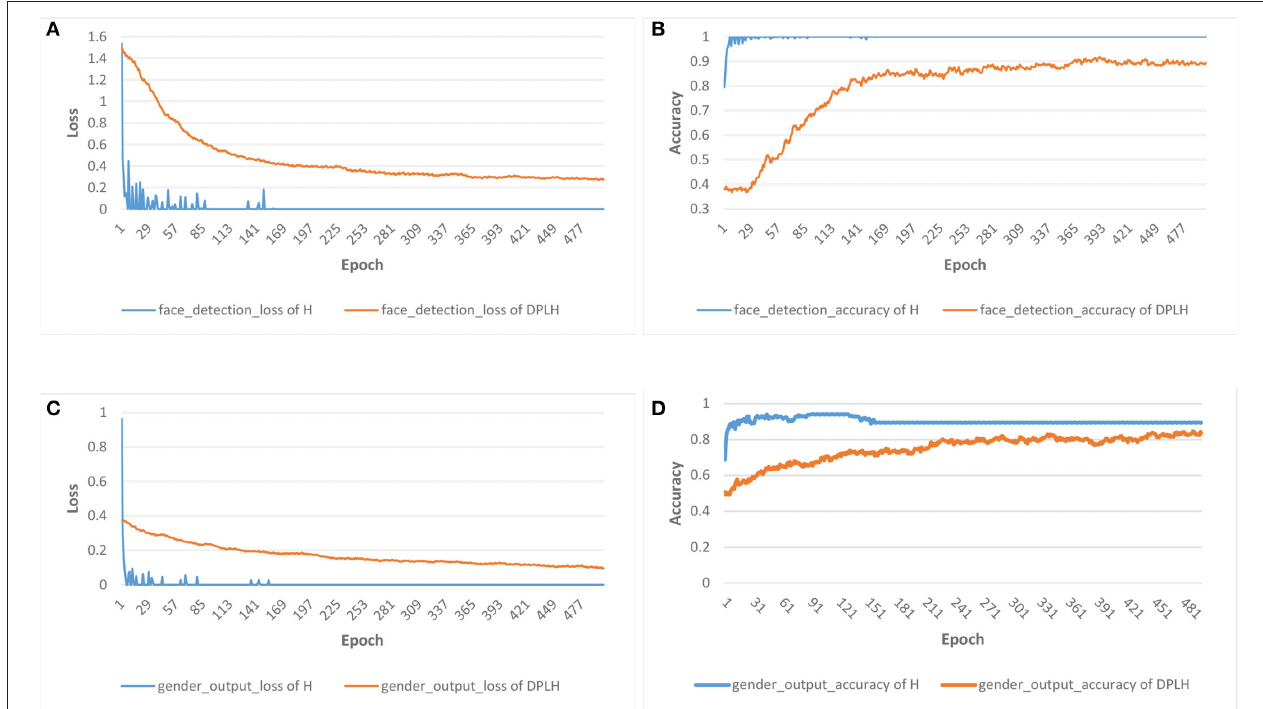
FIGURE 3 | Results for the loss and accuracy of face detection and gender classification on HyperFace (H) vs. DPLH. (A) Loss of face detection. (B) Accuracy of face detection. (C) Loss of gender classification. (D) Accuracy of gender